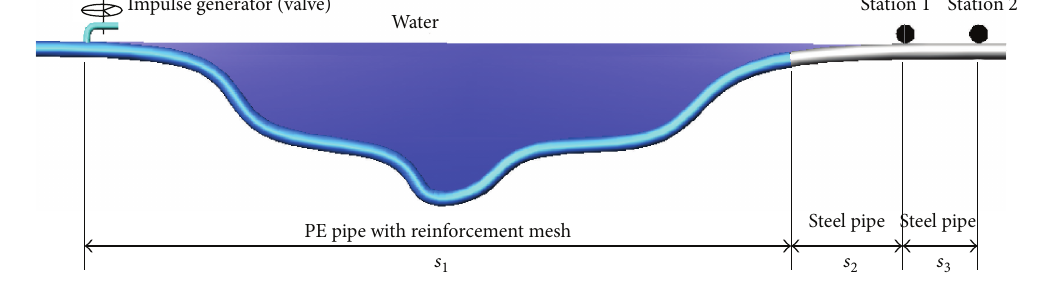
Figure 5: Schematic of wave speed measurement in the field.